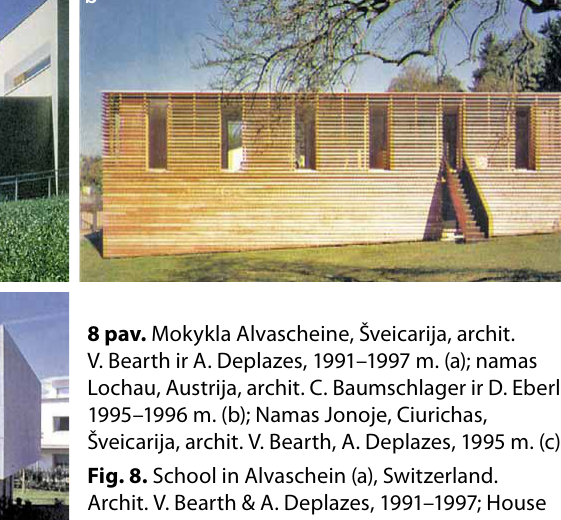
Fig. 8. School in Alvaschein (a),